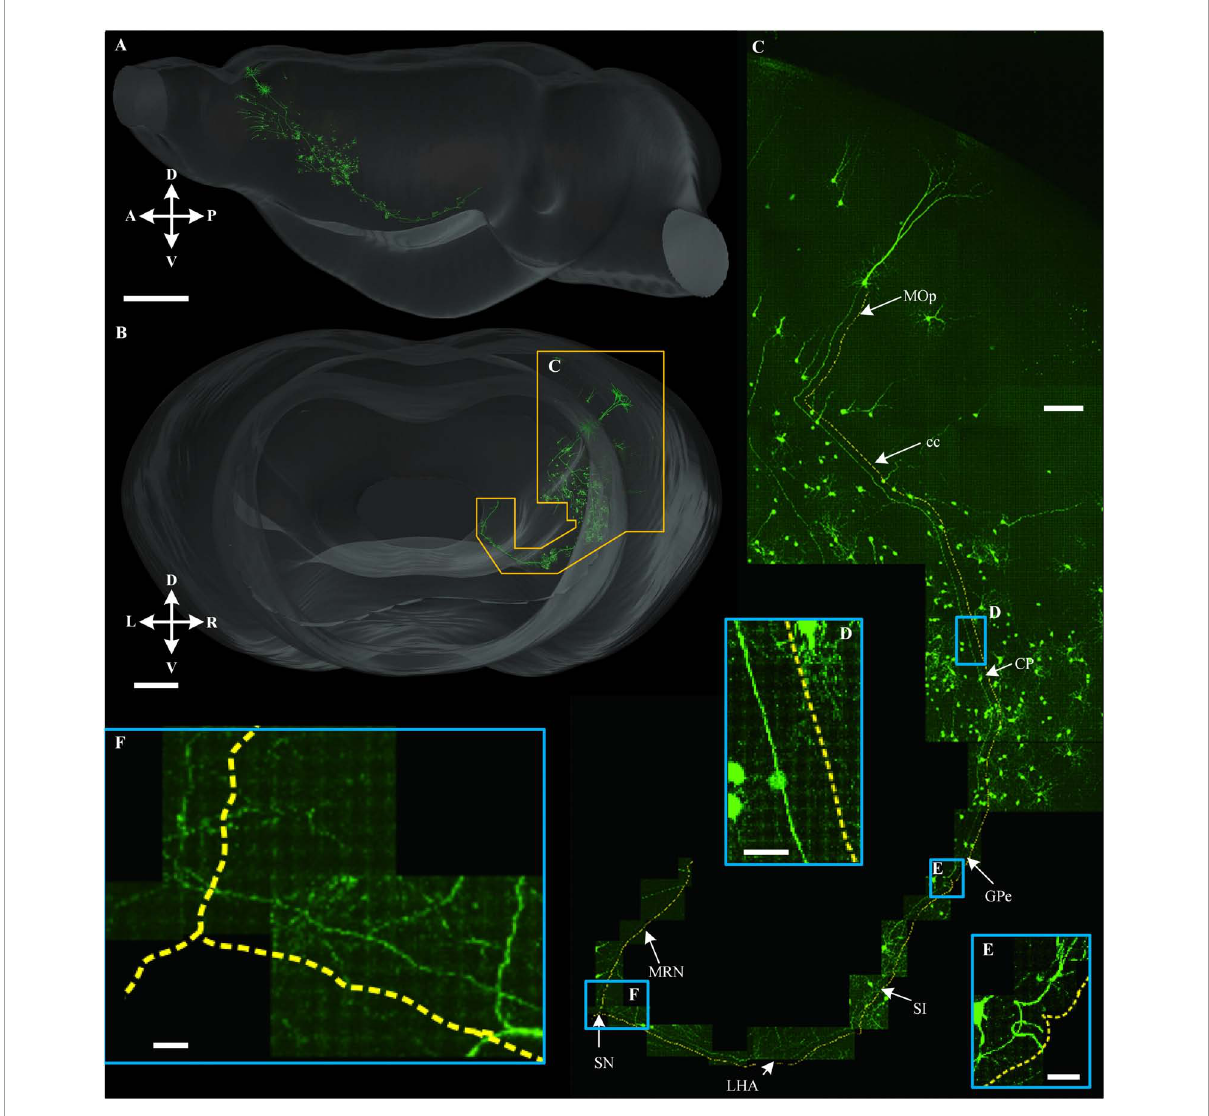
FIGURE9 Long-range tracing of a neuron that projected to the cholinergic neuron in ventral CP. (A,B) 3D reconstruction of a long-range projection neuron to the cholinergic neuron in ventral CP and the signal distribution near this neuron in sagittal view (A) and horizontal view (B) , respectively. (C) An enlarged view of the area is indicated by the orange special-shaped box in (B) . The yellow dotted line was parallel with a long-range fiber path from the soma. (D–F) Enlarged views of the area are indicated by the corresponding blue boxes in (C) . Scale bars: (A) 1 mm, (B) 500 µ m, (C) 100 µ m, and (D–F) 20 µ